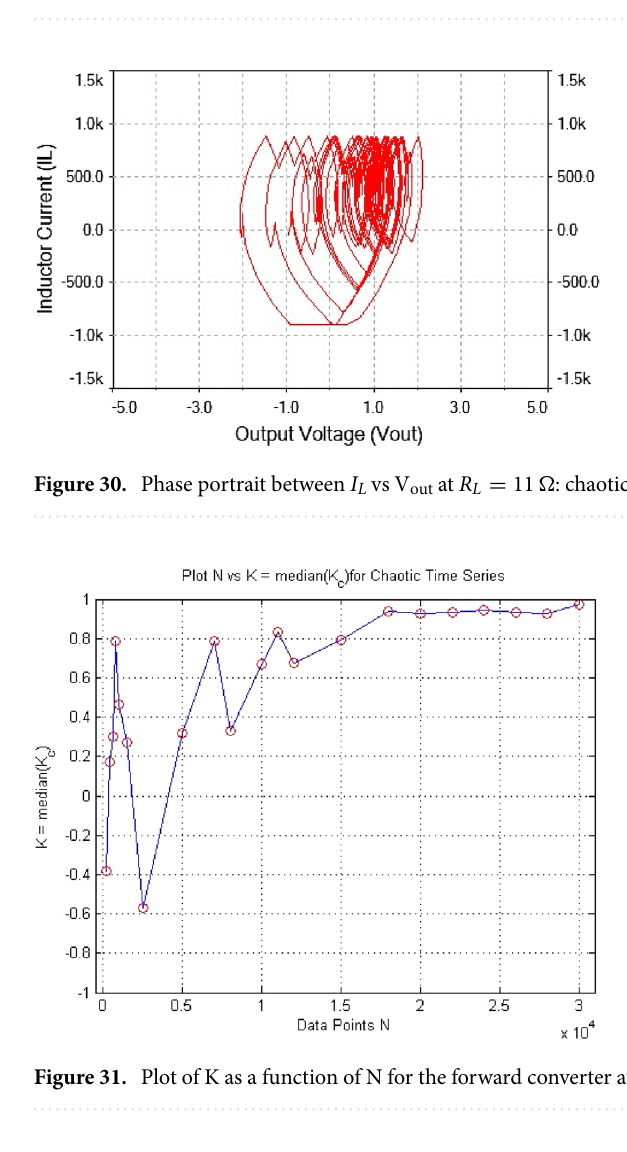
Figure 29. Inductor current waveform for forward converter at R L = 11 (cid:31) .